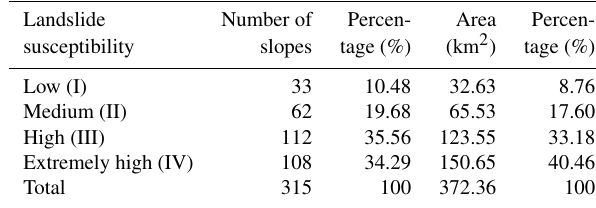
Table 3. Number and area of slopes of four hazard grades.